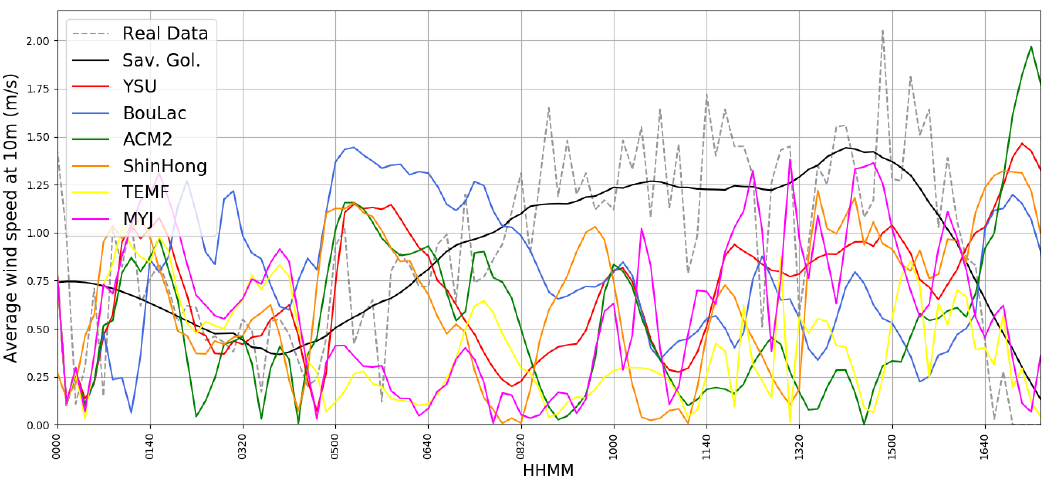
Figure 13. Simulated U10M timeseries compared with real GL U10M timeseries, 04 / 04 / 2016, dotted grey: real data, black: Savitsky–Golay smoothing of real data, red: simulated data with YSU parametrization, blue: simulated data with BouLac parametrization, green: simulated data with ACM2 parametrization, orange: simulated data with ShinHong parametrization, yellow: simulated data with TEMF parametrization, purple: simulated data with MYJ parametrization.